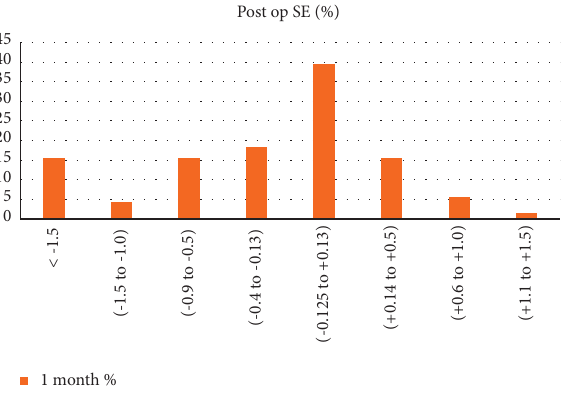
Figure 2: Postoperative refractive cylinder.